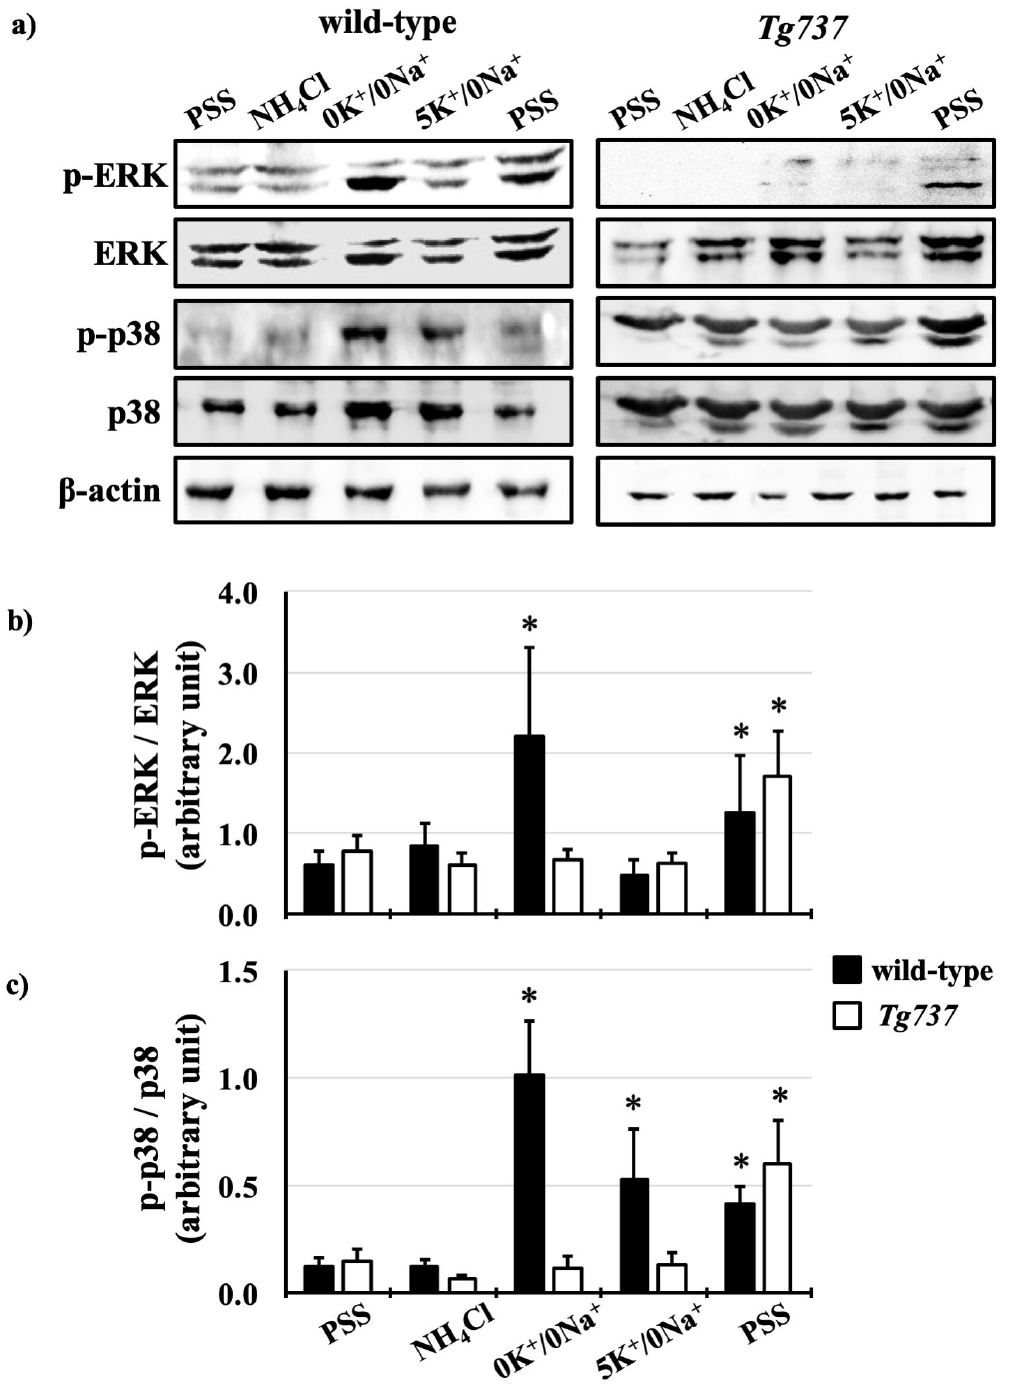
Figure 8. E ff ect of K + on ERK1 / 2 and p38 phosphorylation during the NH 4 Cl pre-pulse in wild-type and Tg737 cells. ( a ) Representative immunoblots show ERK1 / 2 and p38 phosphorylation in wild-type and Tg737 cells as they are exposed to di ff erent solutions during the NH 4 Cl pre-pulse. ( b,c ) Bar graphs show mean p-ERK / ERK and p-p38 / p38, respectively. * denotes p < 0.05 as compared to control conditions. For ERK1 / 2, N = 8 for wild-type cells and N = 8 for Tg737 cells; for p38, N = 7 for wild-type cells and N = 5 for Tg737